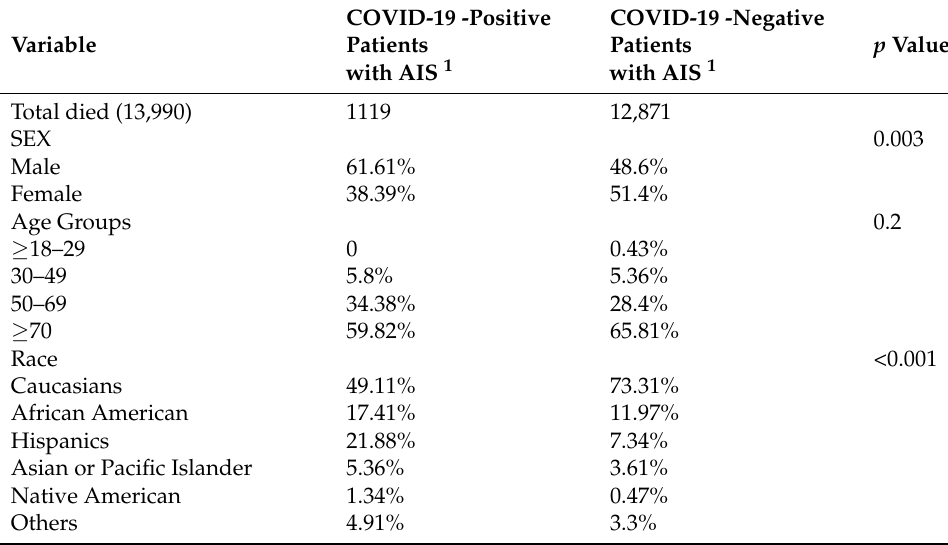
Table 3. Mortality breakdown for COVID-19-positive patients with acute ischemic stroke and COVID- 19-negative patients with acute ischemic stroke.